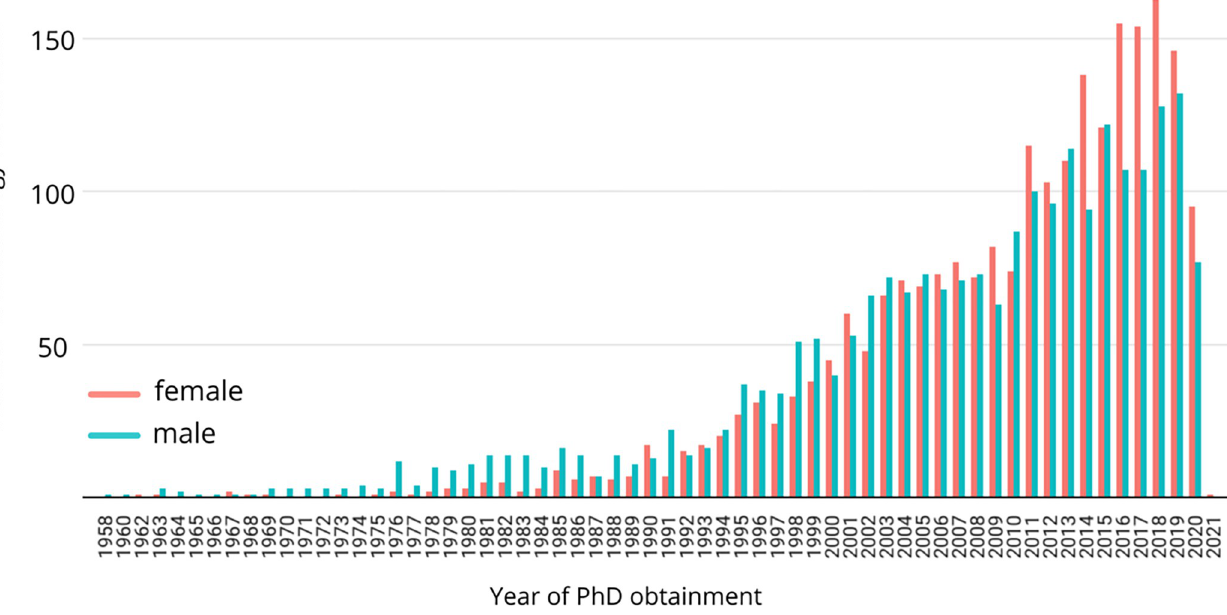
Here we evidence the number of researchers with the highest degree as Doctorate (PhD) or Master’s (MSc), and the number of published papers, patents, advisorships, and other publications related to researcher sex.